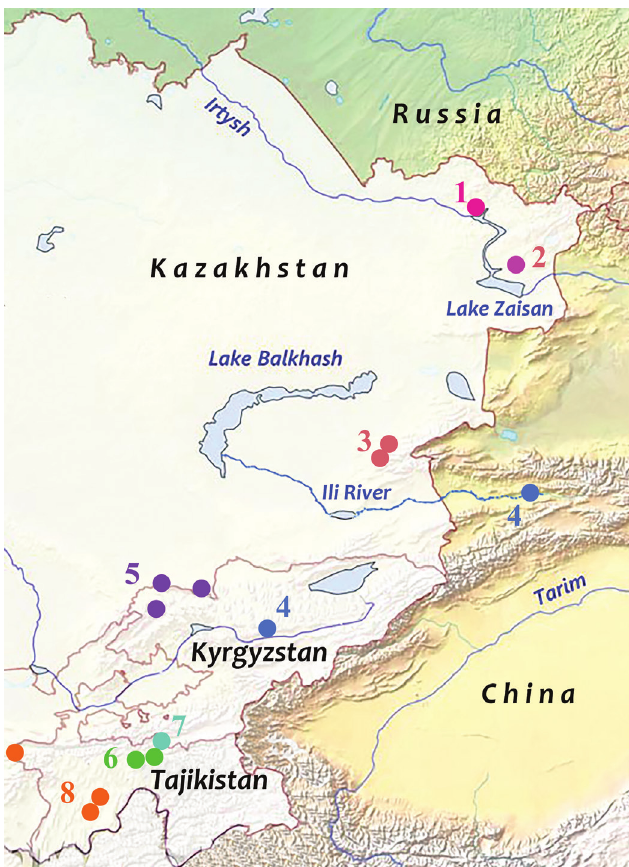
Figure 3. Locations of the analyzed samples of M. ala , M. kotshubeji and M. enarea 1 type-locality of M. ala irtyshica (Kazakhstan, Zyryanovsk district, Oktyabrsk, 49.62°N, 83.62°E) 2 type-locality of M. ala zaisanica (Kazakhstan, Kurtchumski Mts, 48.47°N, 84.12°E) 3 M. ala ala (Kazakhstan, Dzhungarian Alatau, Kyzylagash and Kopal) 4 M. ala bicolor (clade b1 ) (China, Kyrgyzstan) 5 M. ala bicolor (clade b2 ) (Kyrgyzstan, Kara-Bura Pass; Kazakhstan, Kirgizski Mts) 6 M. kotshubeji kotshubeji (Tajikistan, Peter the Great Mts) 7 M. kotshubeji bundeli (Tajikistan, border with Kyrgyzstan, Alai Mts, 39.42°N, 71.62°E) 8 M. enarea